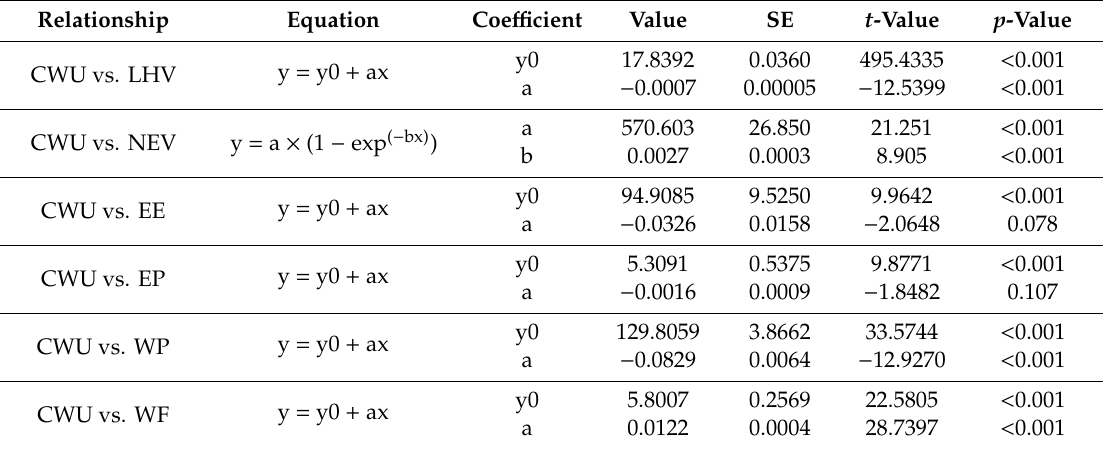
Table 4. Estimated coe ffi cients, standard error, t - and p -value of the fitted equations between crop water use and energy and water indicators of Saccharum under changing irrigation and growing